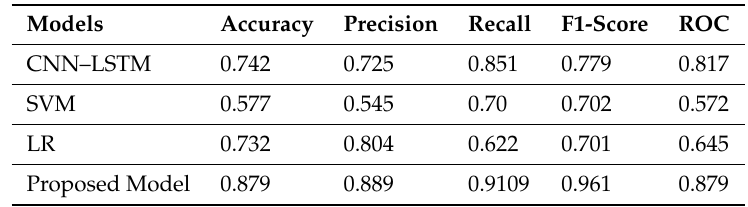
Table 13. Summary of